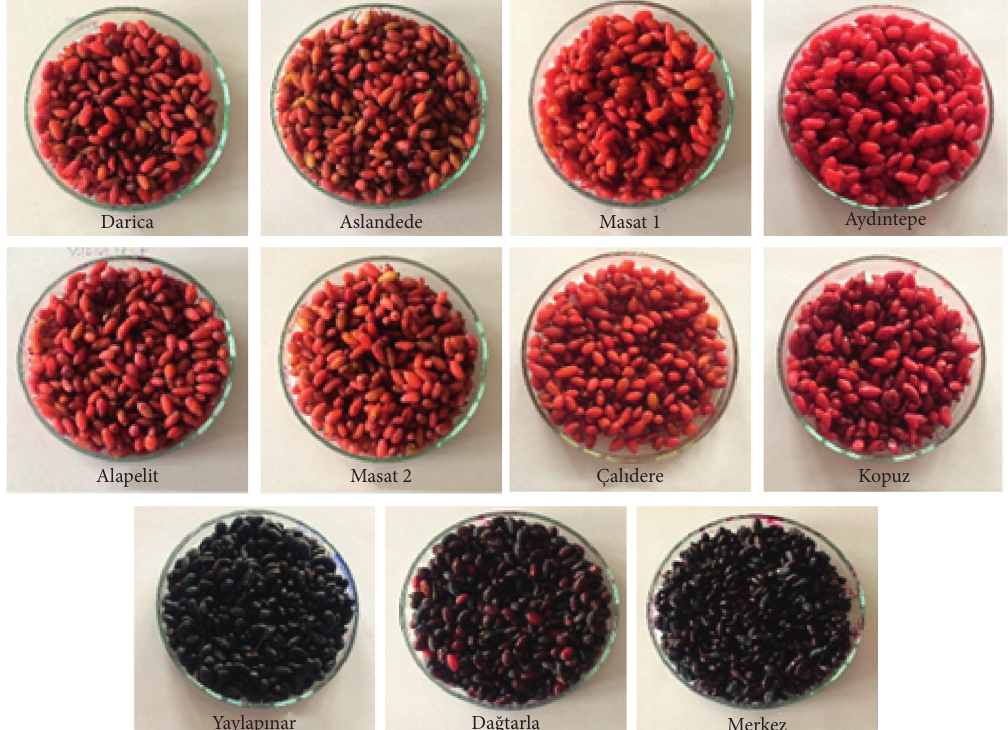
Figure 2: Berberis vulgaris L. and Berberis crataegina DC. samples used in the research.